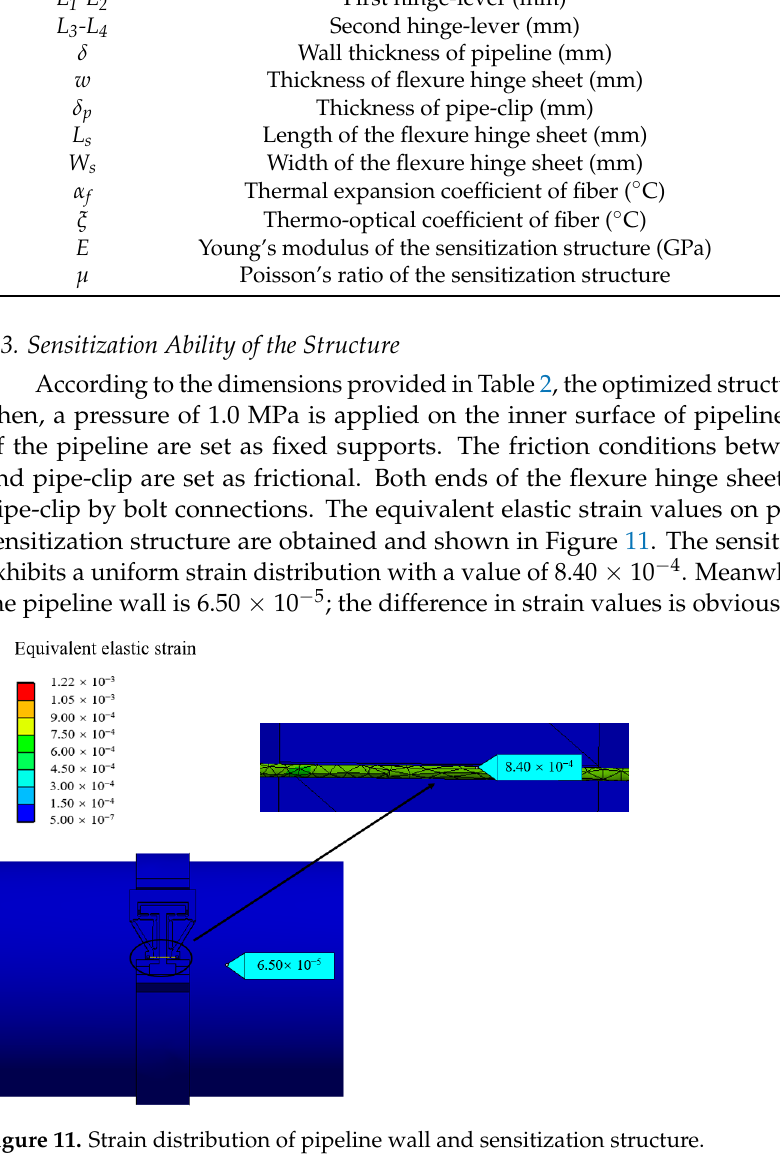
Table 2. Dimensions and material parameters of the sensitization structure.